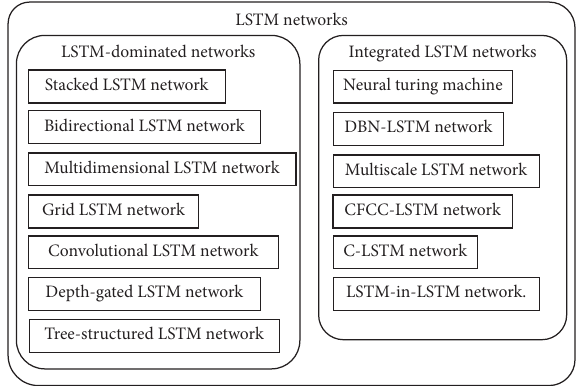
Figure 2: Classification of LSTM networks.